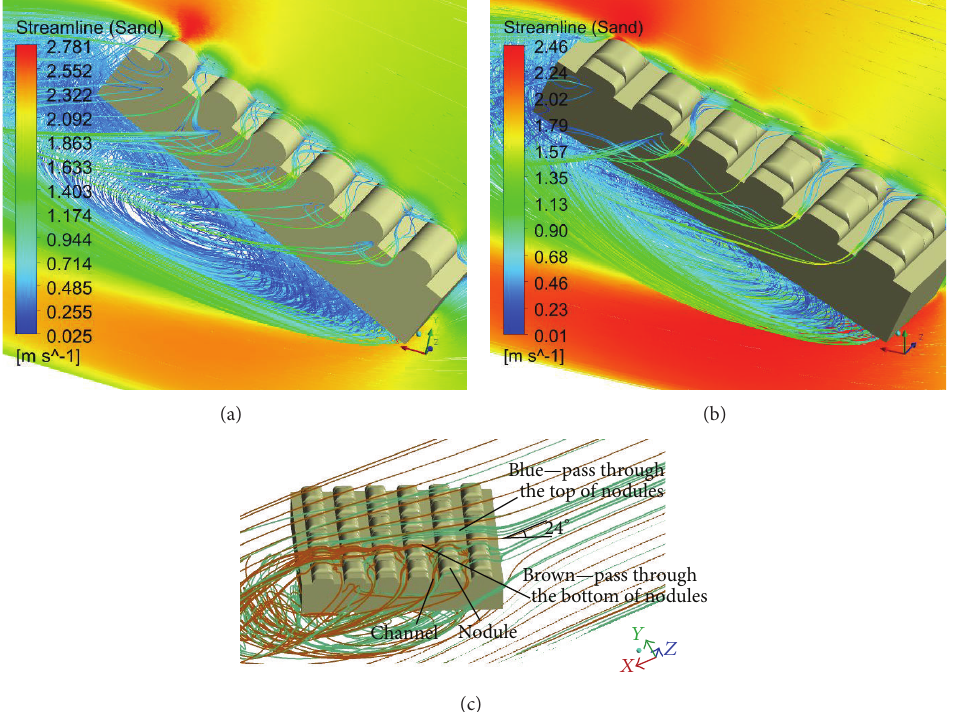
Figure 13: The abrasive trajectories for the two models: (a) the abrasive trajectories for the RMM; (b) the CSM; and (c) a detailed depiction of the abrasive trajectories for the